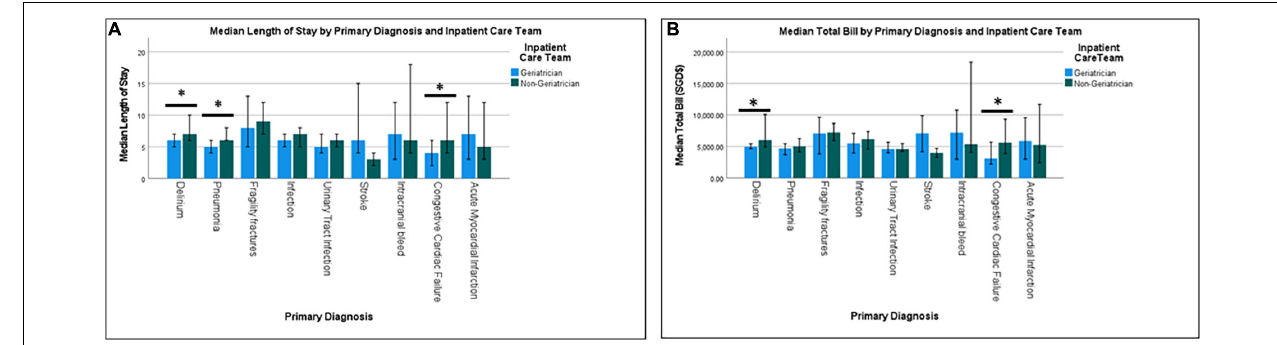
FIGURE 1 | Median length of stay (A) and median total bill (B) by primary diagnosis and inpatient care team.